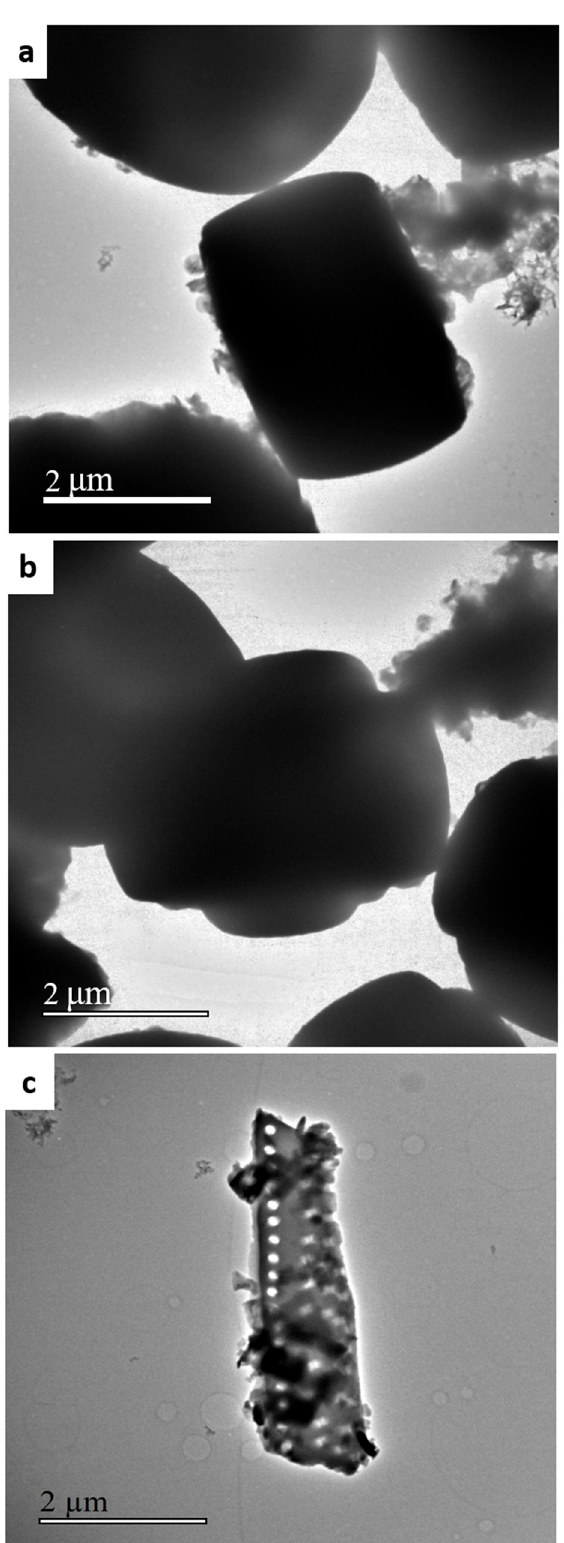
Figure 4. TEM micrographs of the zeolitic product ZSM-5-diatomite observed by different perspectives ( a , b ), and also showing the intergrowth zeolite-diatomite ( c ).